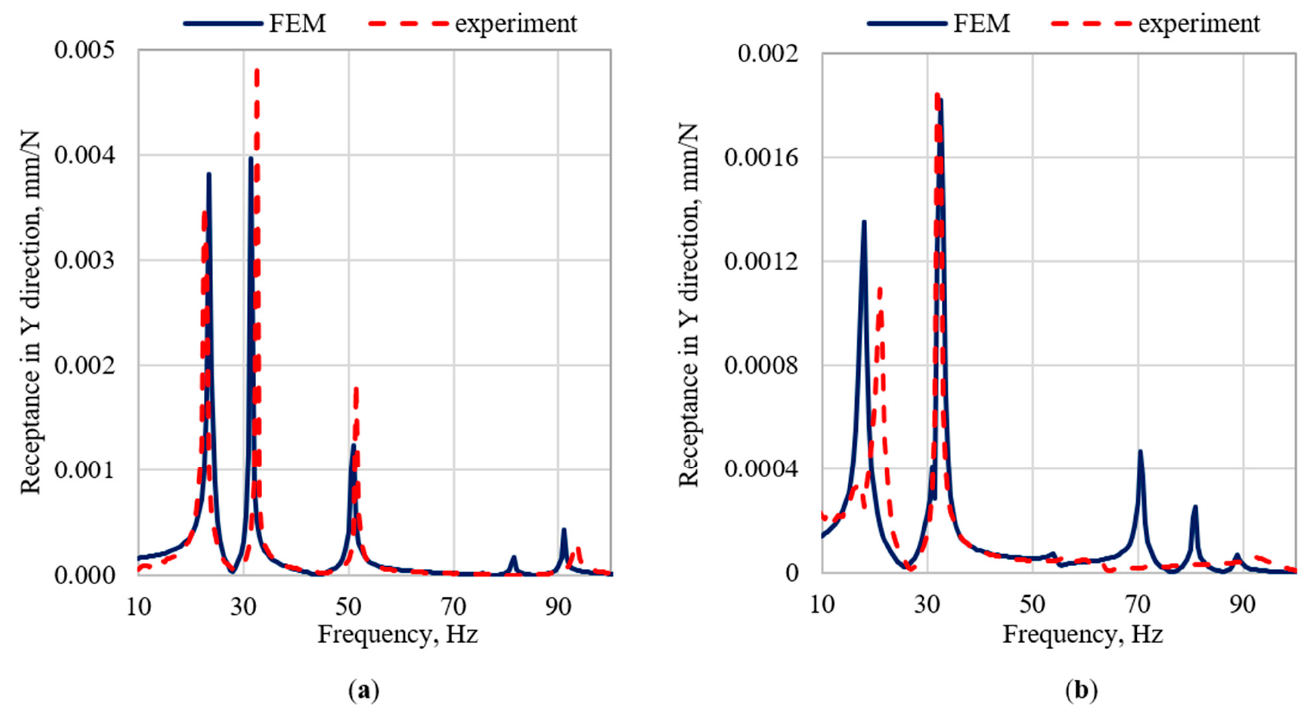
Figure 6. Comparison of selected receptance functions in Y direction ( a ) for the frame and ( b ) for the frame with the robot.